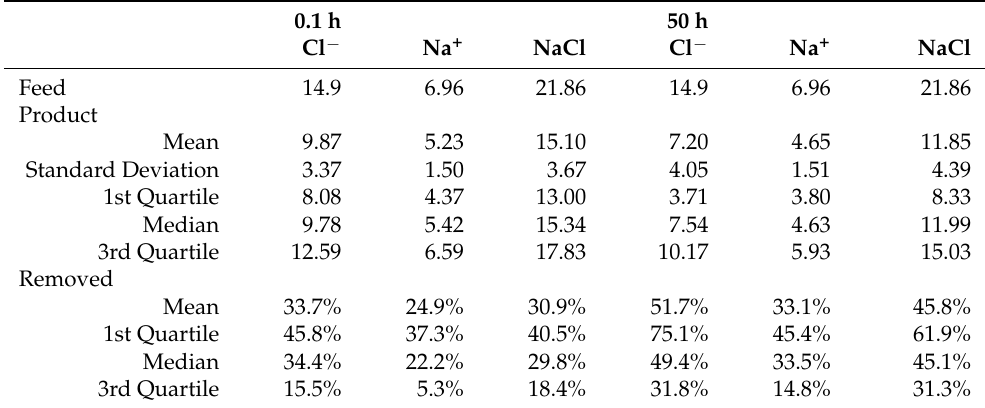
Table 3. Modelled removal of Na + and Cl − ions for Well 1 (Table 1) after 0.1 h and 50 h using a metal polymer (Figure 18).